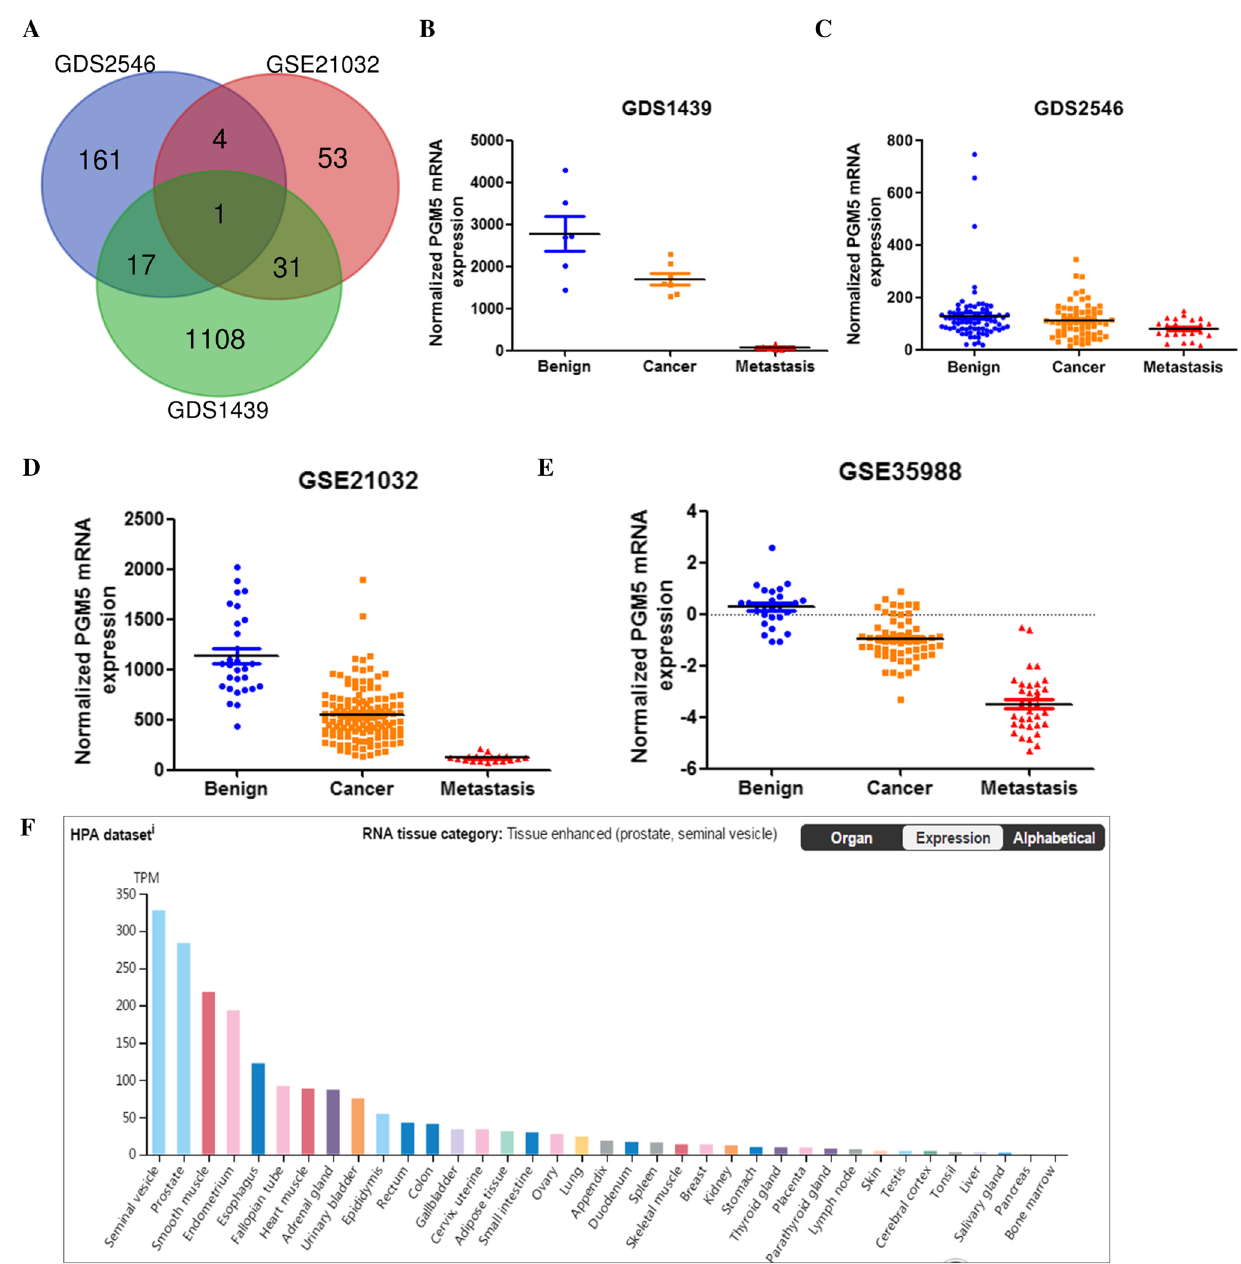
Fig. 1 Associations between PGM5 expression and prostate cancer progress. A Identification of only one common DEGs from the 3 cohort profile data sets (GSE21032, GDS1439, and GDS2546) using an online tool Calculate and draw custom Venn diagrams (http:// bioin forma